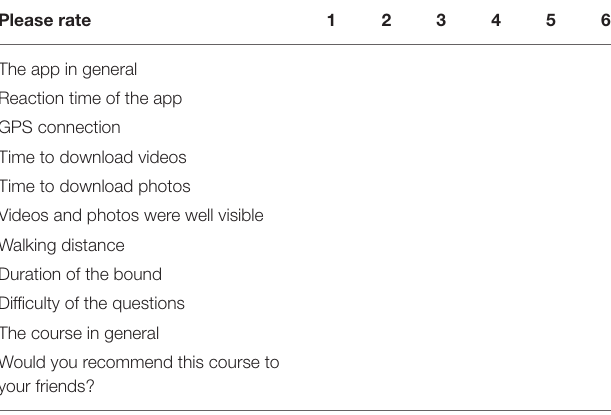
TABLE 2 | Likert rating scale of the evaluation